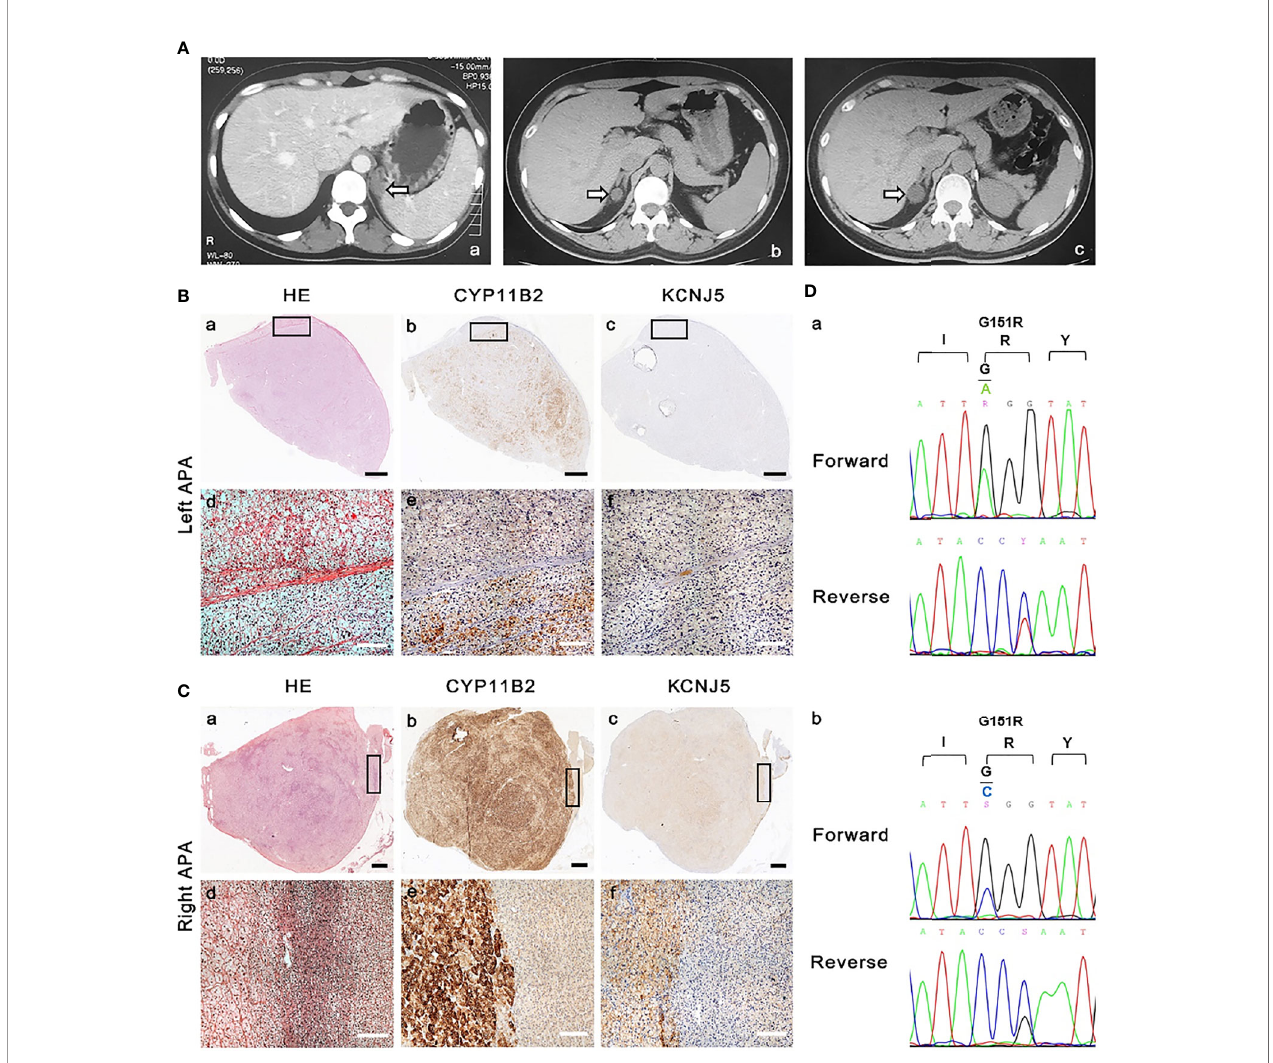
FIGURE 1 | Imaging, histology, and genetic studies of left and right aldosterone-producing-adenomas. (A) Adrenal computed tomography scans according to year of acquisition: a. 2004; b. 2014; c. 2017. The arrows indicate the adrenal adenoma with the largest diameter. Hematoxylin – eosin (HE) staining and immunohistochemistry (see Document, Supplemental Digital Content 1 , which describes detailed methods) of (B) left and (C) right aldosterone-producing adenomas: a, d. HE staining; b, e. CYP11B2 immunohistochemical staining of aldosterone synthase; c, f. immunohistochemical staining of KCNJ5 . Black scale bar=2mm; white scale bar=100 m m. CYP11B2, aldosterone synthase; KCNJ5, G-protein – coupled inwardly rectifying potassium channel. (D) Sanger DNA sequences of mutations in KCNJ5 gene and corresponding amino-acid change (see Document, Supplemental Digital Content 1 ): a. Left APA: c. 451G>A, p.G151R; b. Right APA: c. 451G>C,